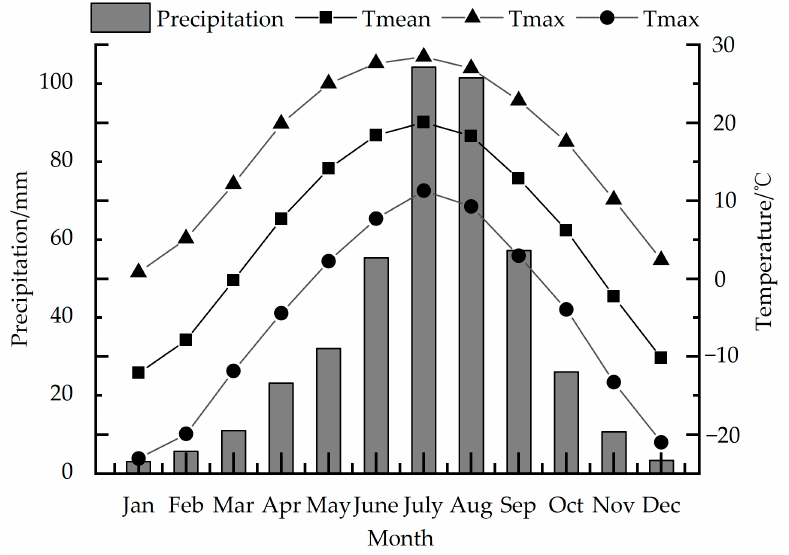
Figure 2. Precipitation, average temperature, maximum temperature and minimum temperature in the study area from 1957 to 2020.